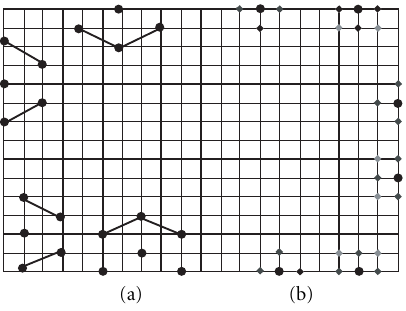
Figure 2: (a) Hexagon and initial star patterns, neighbouring points of the initial star are shown by grey colour. (b) Expanded star pat- tern for no edge points.